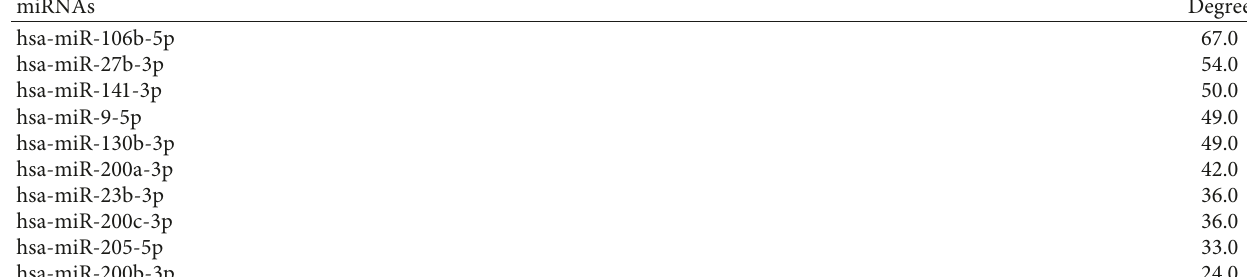
Table 2: The degree of miRNAs (top 10) in the miRNA-gene network.